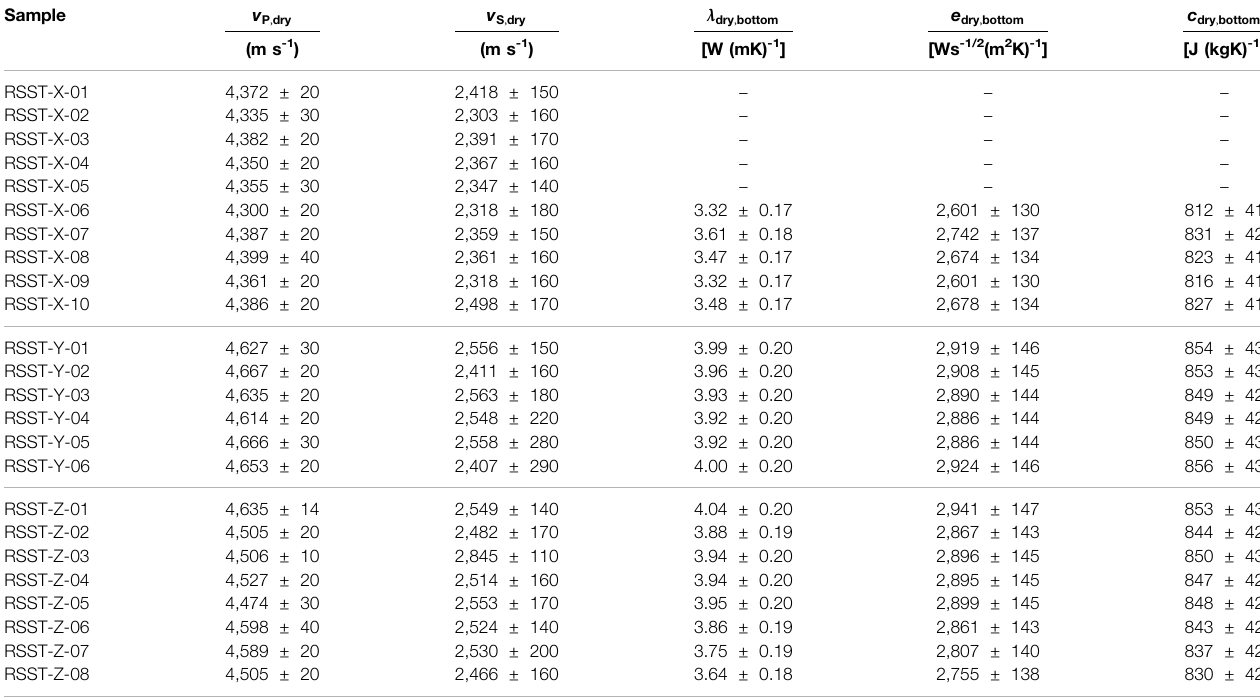
TABLE 2 | Ultrasound velocities, thermal conductivity, thermal effusivity, and speci fi c heat capacity derived by laboratory measurements for Ruhr sandstone from Oberste quarry in Dortmund. All measurements were conducted at ambient conditions. The abbreviations RSST and e.g., X indicate the rock sample Ruhr sandstone and the drilled direction from the parent cube,